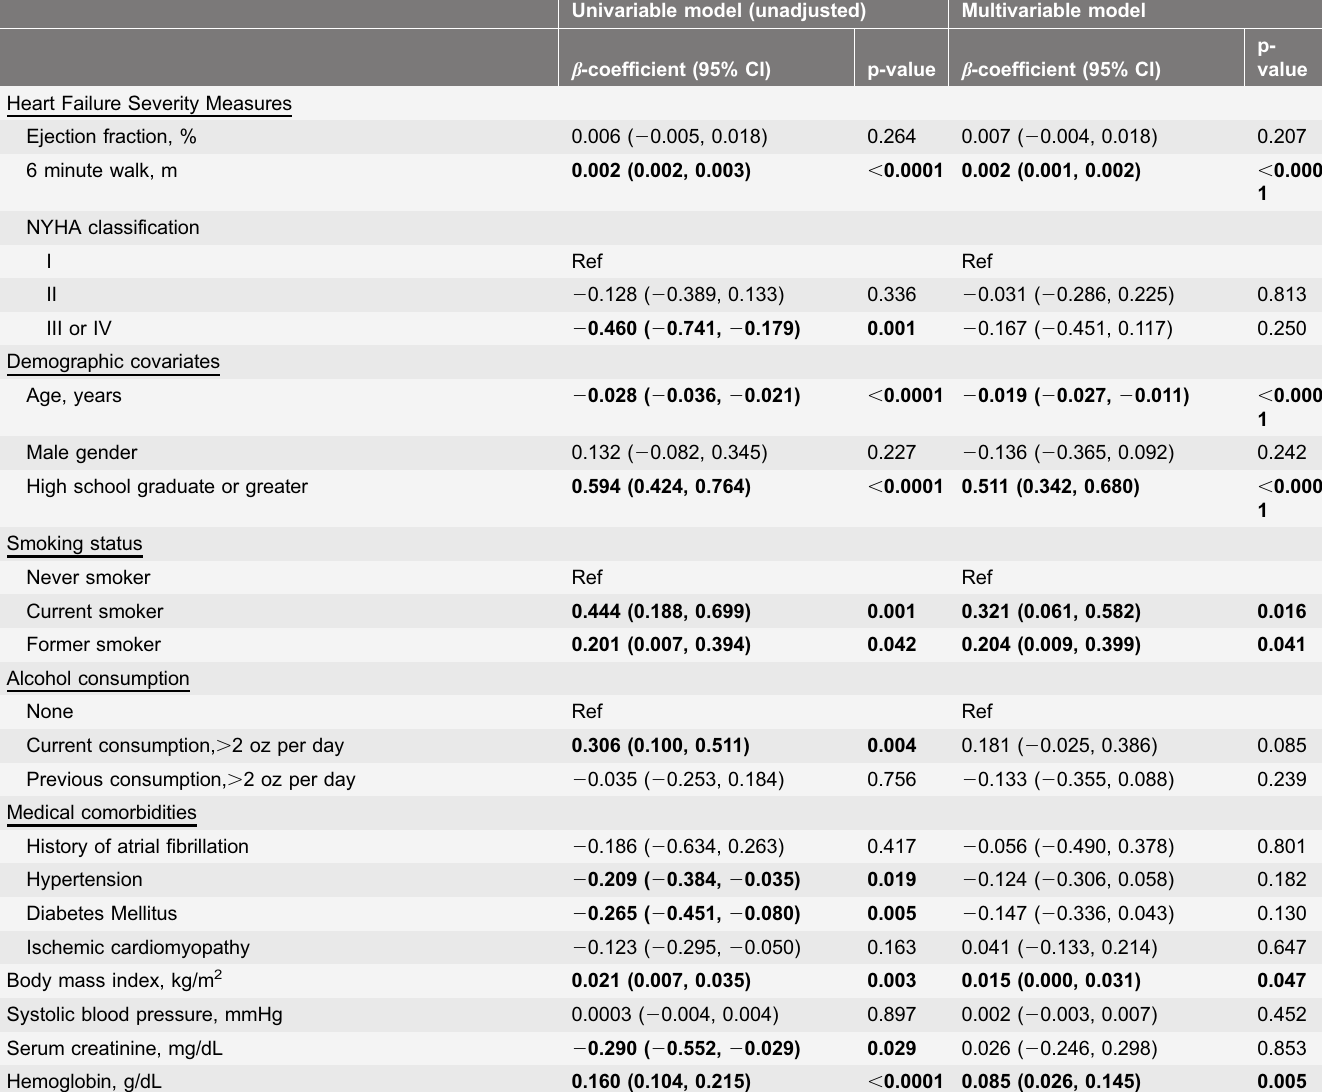
Table 2. Predictors of cognitive function (as measured by the Mini-Mental Status Exam) in univariable and multivariable regression